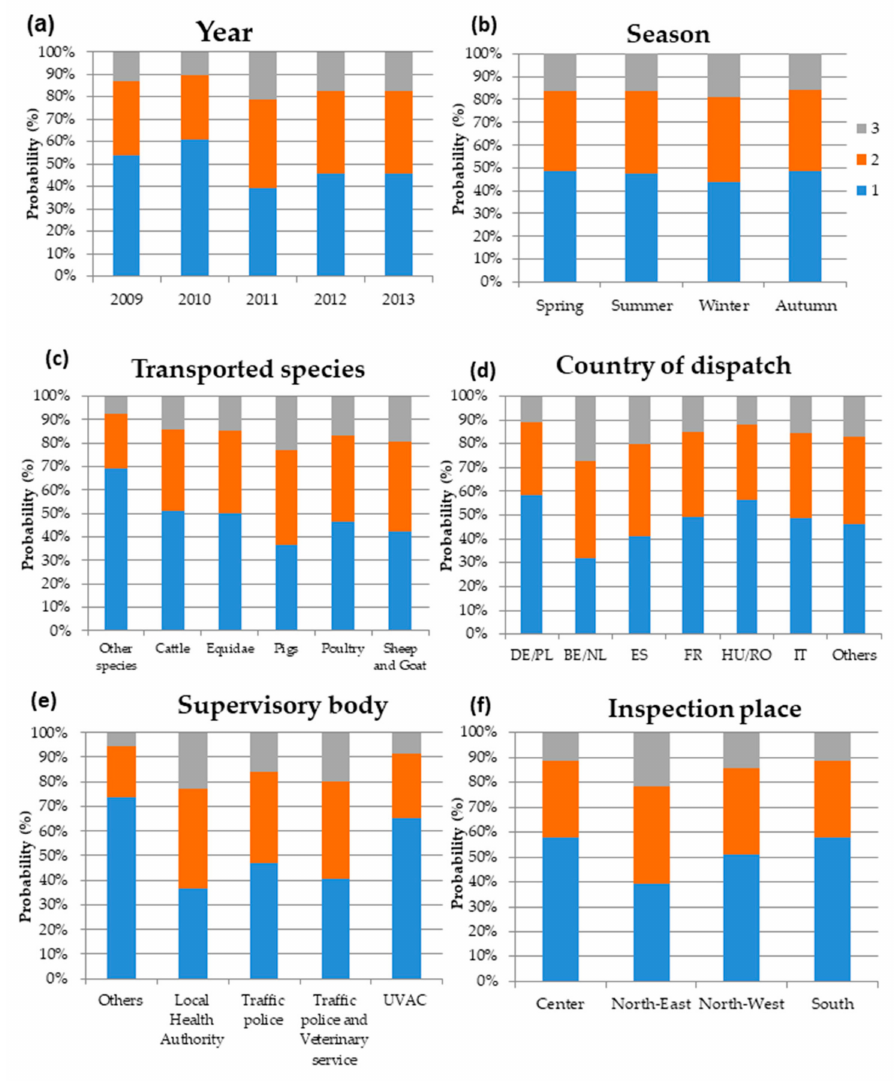
Figure 2. Probability of a more severe infringement being uncovered during on-road inspections (1 (blue) = less severe infringements, 2 (orange) = medium severe infringements, 3 (grey) = the most severe ones) associated with year ( a ), season ( b ), transported animal species ( c ), dispatch country ( d ), supervisory body ( e ), and the place of inspection in Italy ( f ).DE / PL: Germany / Poland; BE / NL: Belgium / the Netherlands; ES: Spain; FR: France; HU / RO: Hungary / Romania; IT: Italy; Other: China; Czech Republic; Denmark; Ireland; Lithuania; Slovakia; Slovenia; United Kingdom; and UVAC: Veterinary O ffi ces for Compliance with EU